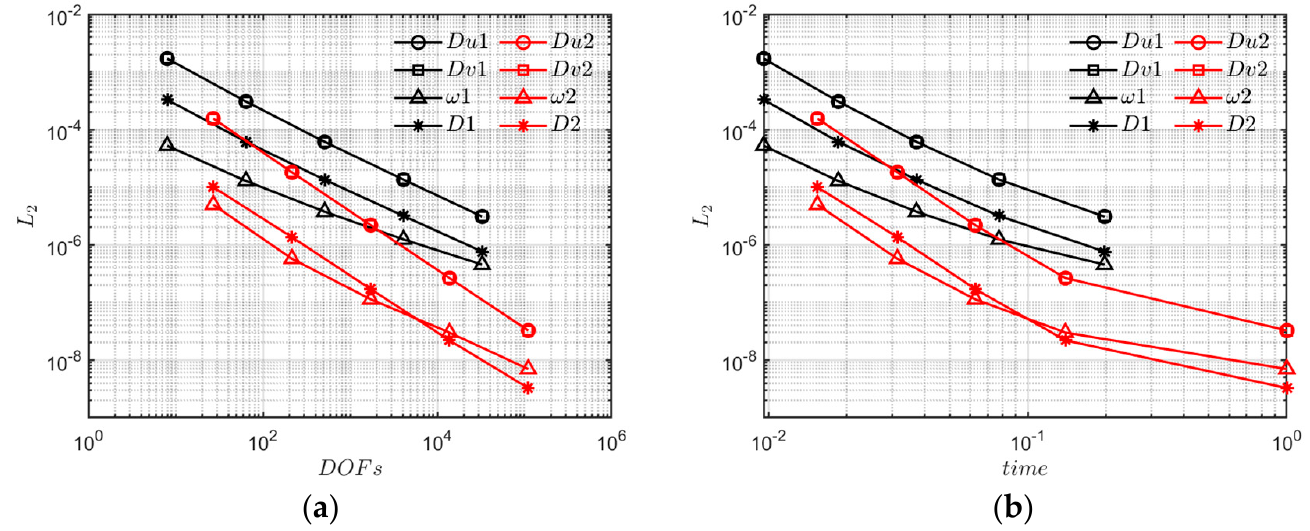
Figure 2. L 2 error versus DOFs and normalized CPU time for water depth D , vertical velocity ω , and horizontal momenta Du and Dv at different approximation orders ( N h = N v = 2(red)) on a sequence of meshes. ( a ) L 2 error versus DOFs; ( b ) L 2 error versus normalized CPU time.